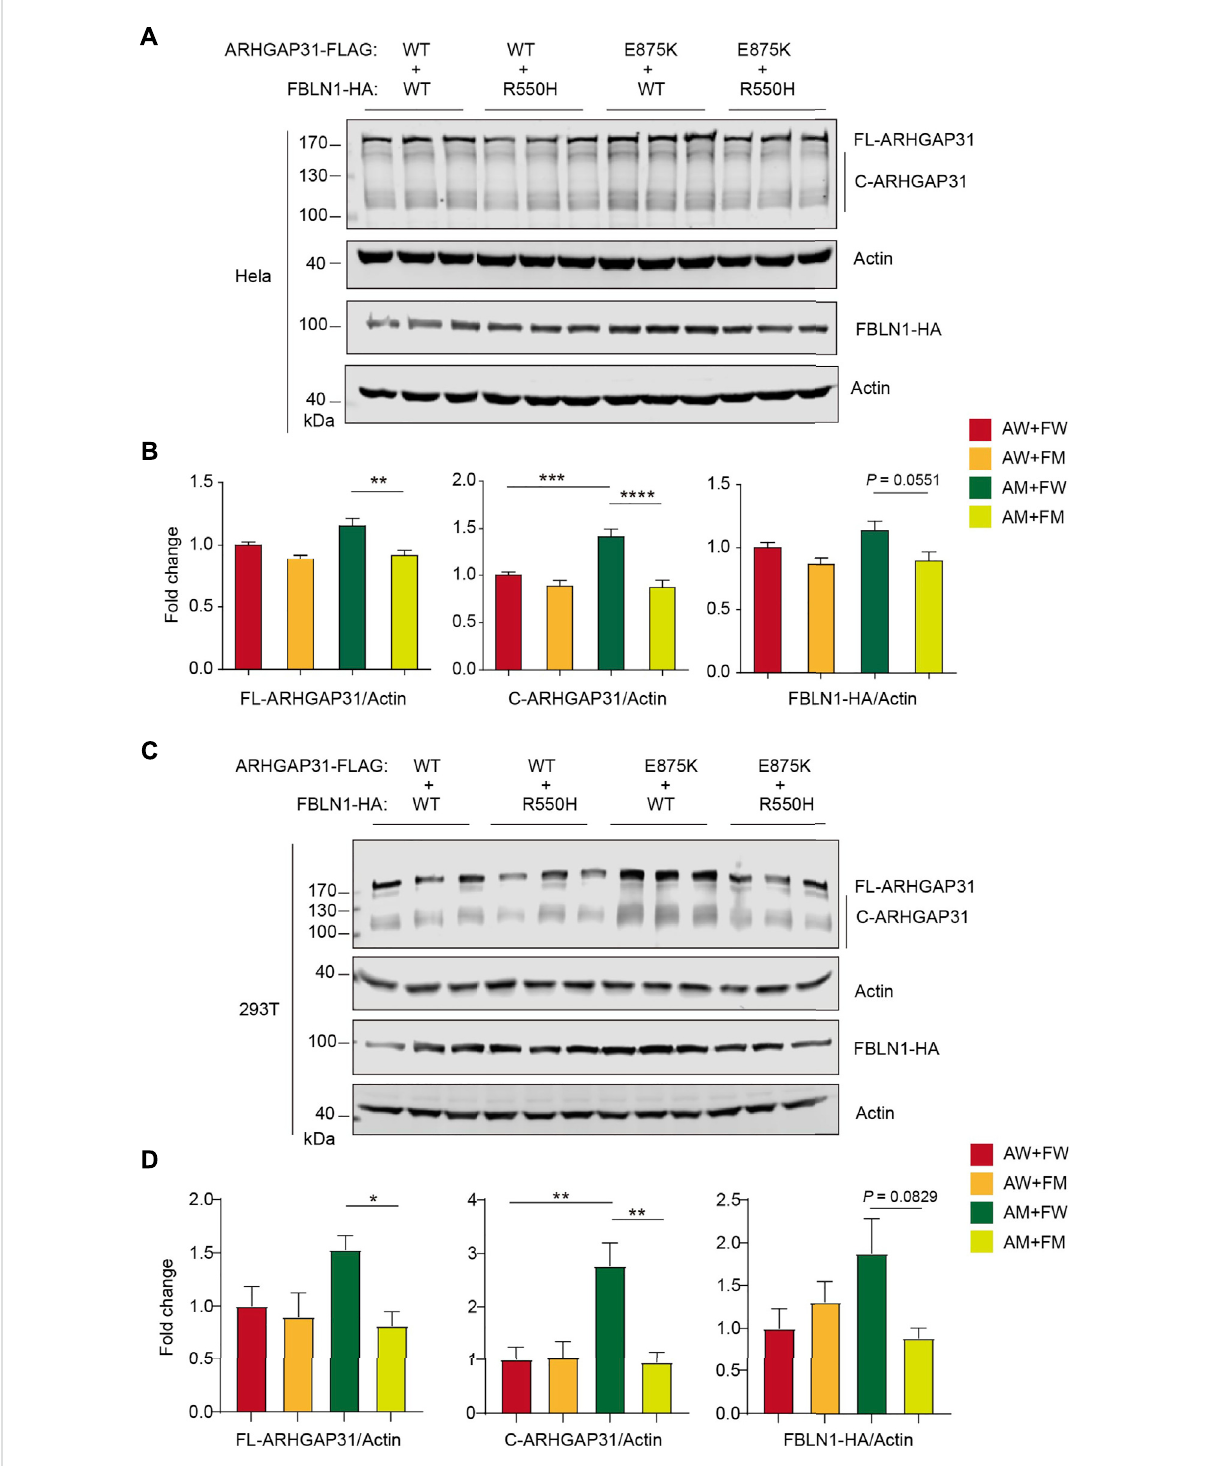
FIGURE 4 Protein expression with ARHGAP31 and FBLN1 variations in vitro . (A) Immunoblotting of exogenous ARHGAP31 and FBLN1 in co-transfected HeLa cells as indicated. (B) Quanti fi cation of (A) . (C) Immunoblotting of exogenous expression of ARHGAP31 and FBLN1 in co-transfected HEK293T cells. (D) Quanti fi cation of (C) . FL-ARHGAP31, full-length ARHGAP31; C-ARHGAP31, cleaved ARHGAP31; AW, wild-type ARHGAP31; AM, mutant ARHGAP31; FW, wild-type FBLN1; FM, and mutant FBLN1. * p < 0.05, ** p < 0.01, *** p < 0.001, and **** p <